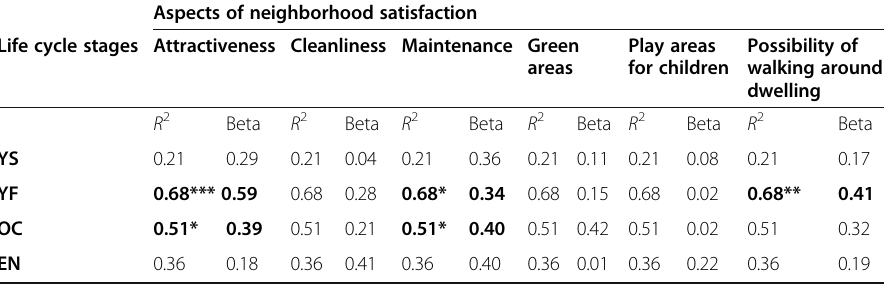
Table 8 Regression analysis results for neighborhood satisfaction Aspects of neighborhood